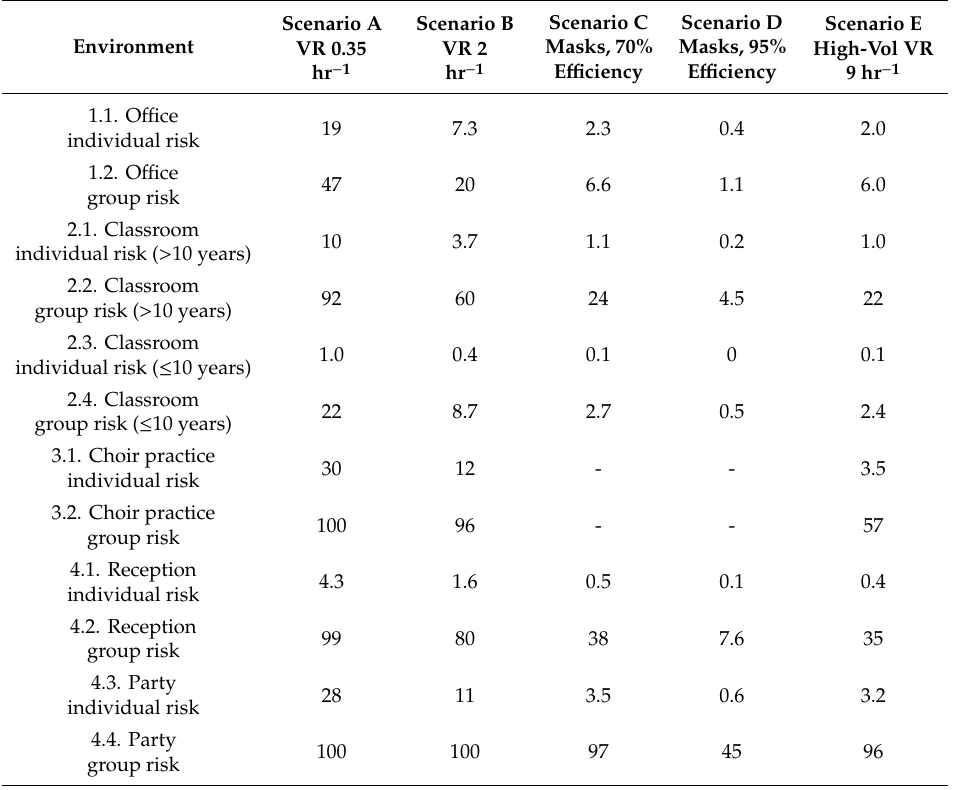
Table 4. COVID-19 infection risk in four example environments for five scenarios. Unit: percent per episode. The individual risk is that of a particular person being infected and the group risk refers to that of at least one person in the